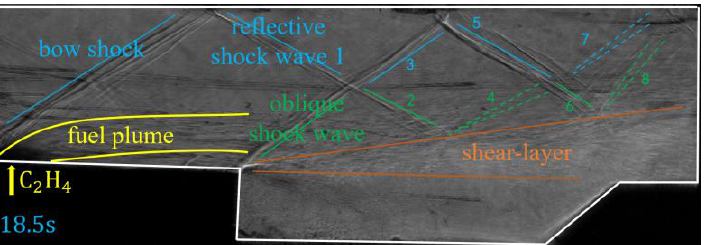
Figure 8. Shadowgraph at Case 11 (1.7D 0 I0.144). 1 — Reflected shock wave, 2 — Intersecting shock waves, 3 — Intersecting shock waves, 4 — Reflected expansion wave, 5 — Reflected shock wave, 6 — Intersecting shock waves, 7 — Intersecting expansion wave, 8 — Reflected shock wave.